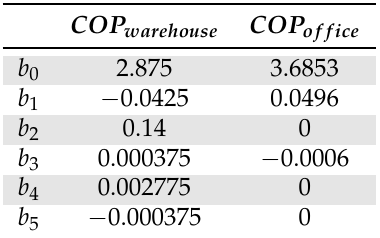
Table 4. Coefficients for coefficient of performance (COP)